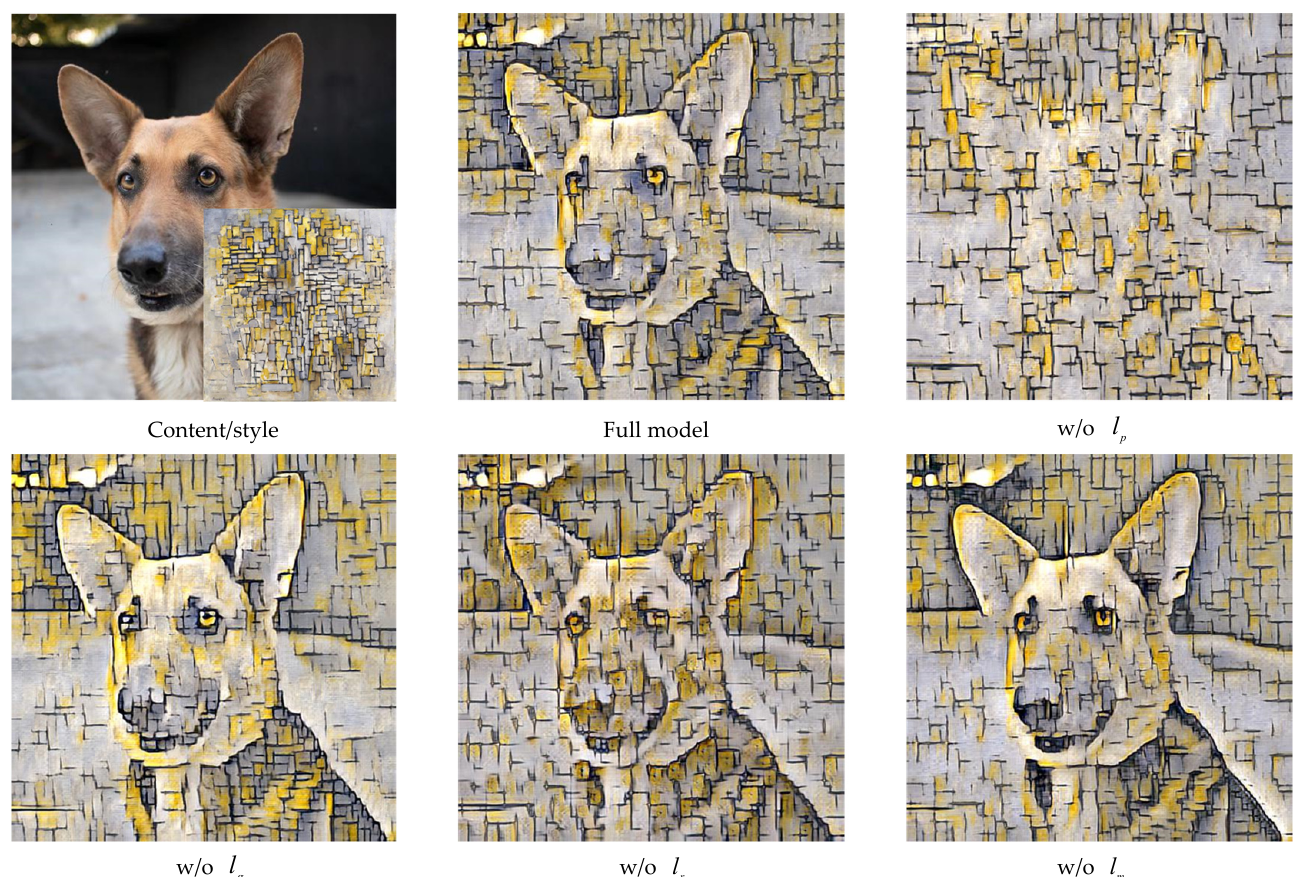
Figure 9. Ablation study of the effects of different loss functions used during training.